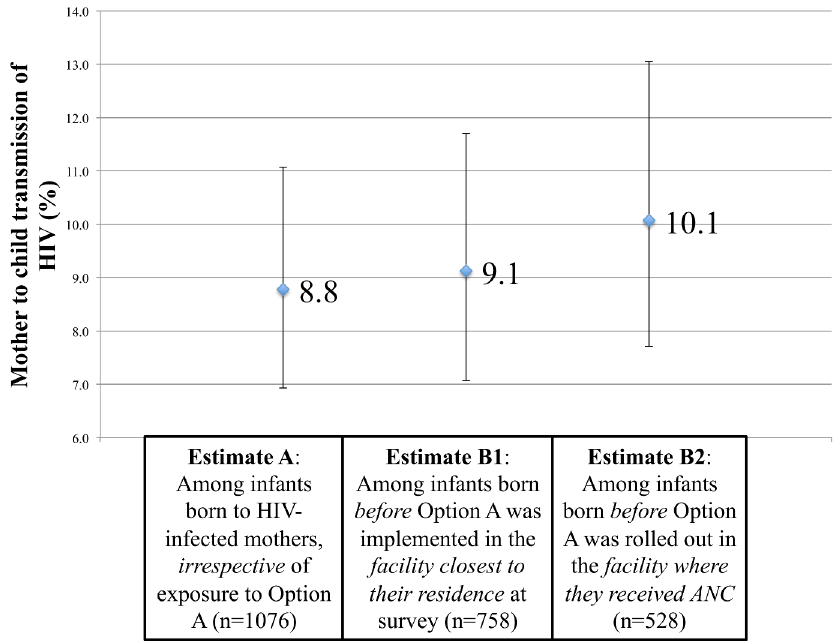
Fig 4. Mother-to-child HIV transmission rate at 9 – 18 months of age in five provinces in Zimbabwe, 2012. The figure shows estimates and 95% confidence intervals adjusted for the survey design. Weighted frequencies are shown on the x-axis. The sample size (unweighted) differs from that listed on Fig 3 due to missing data regarding the infants ’ status for a few mother-infant pairs.